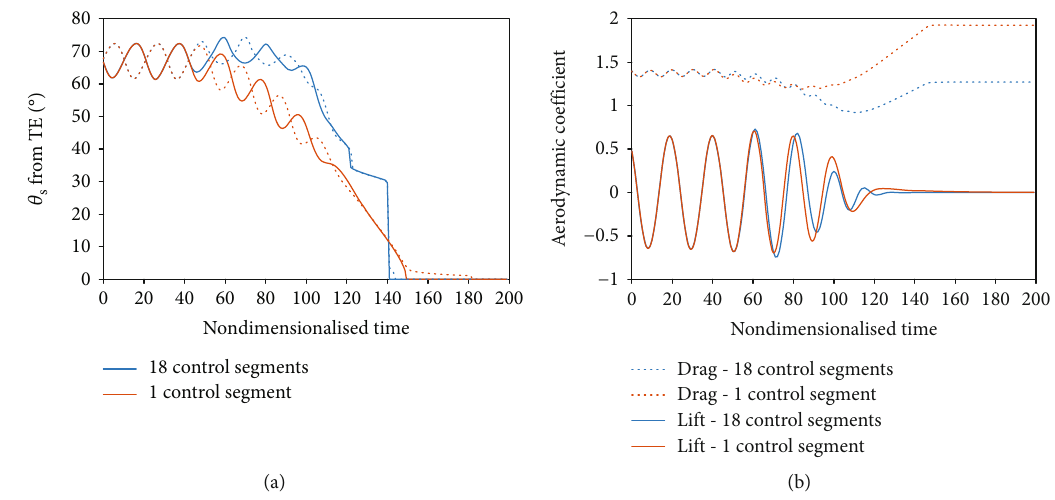
Figure 11: E ff ect of the 18-segment optimised suction control on fl ow at Re = 180 : (a) separation angle with a dotted line for values on the upper cylinder and a solid line for the lower half and (b) lift and drag coe ffi cients (with lift plotted by the lower curves).